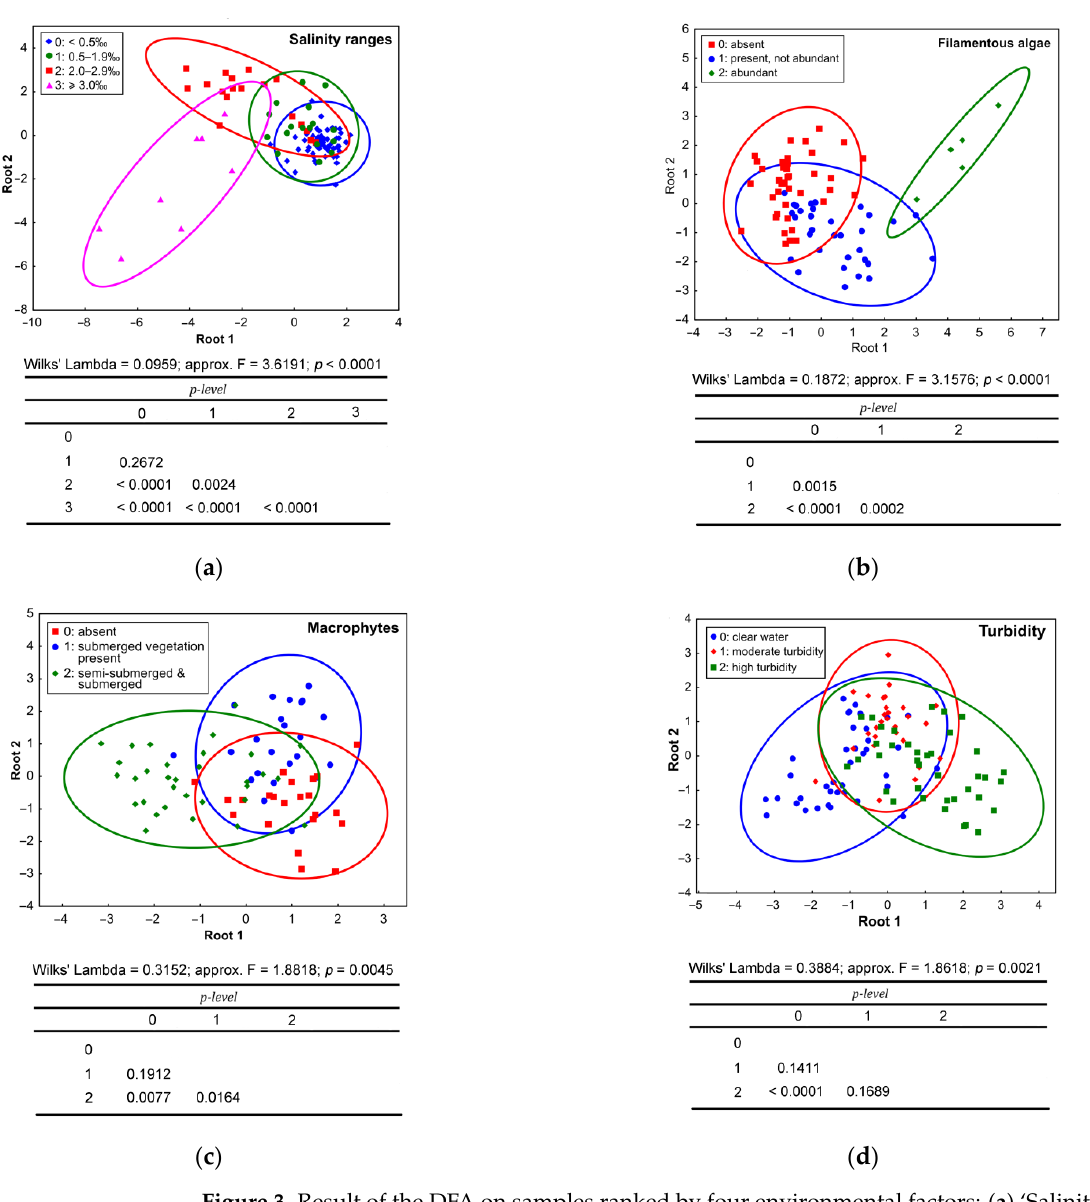
Figure 3. Result of the DFA on samples ranked by four environmental factors: ( a ) ‘Salinity ranges’; ( b ) ‘Filamentous algae’; ( c ) ‘Macrophytes’; and ( d ) ‘Turbidity’. Significant differences between vari- ables of each factor are presented under the diagrams by p -values. Filamentous algae, Macrophytes, and Turbidity represent the data within salinity ≤